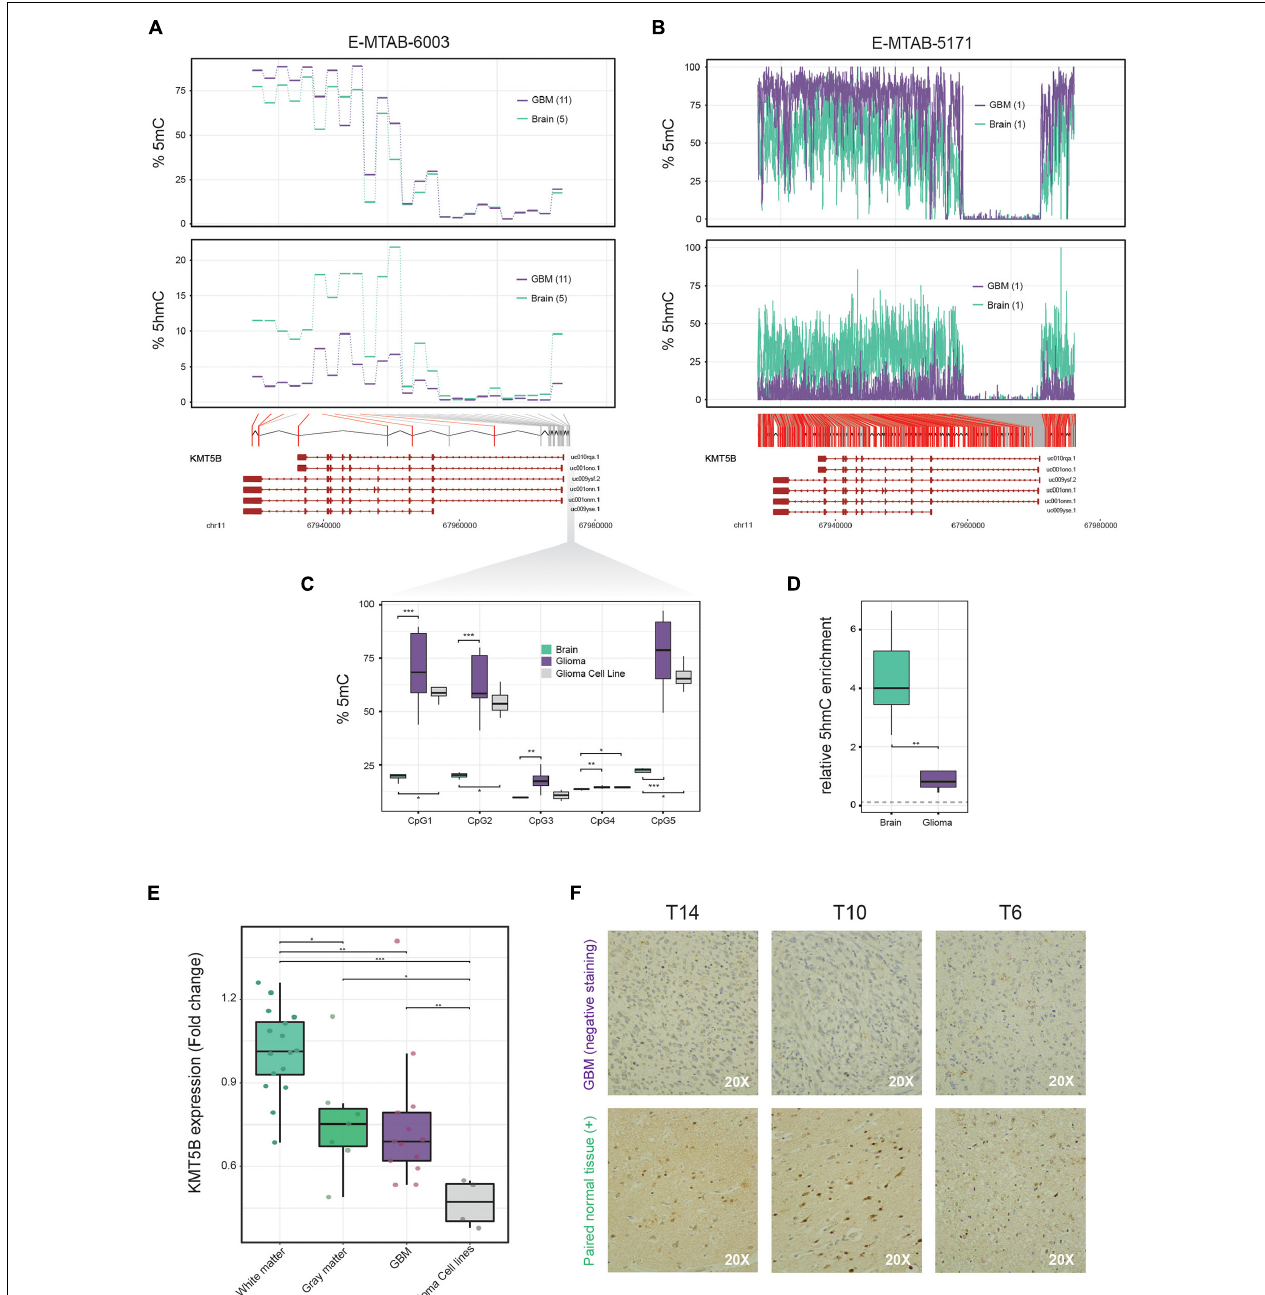
FIGURE 1 | 5mC and 5hmC profiling along the KMT5B locus in brain and glioblastoma multiforme (GBM) samples and analysis of KMT5B expression in brain, GBM and GBM cell lines. (A) Line plots represent percentage of average 5mC ( upper panel ) and 5hmC values ( lower panel ) corresponding to 25 CpG positions in the KMT5B gene for five control brain and eleven GBM samples, depicted in blue and violet, respectively. Data were obtained from a genome-wide Illumina HumanMethylation 450 K array (E-MTAB-6003). Welch t -tests were applied for each CpG and those that were significant are depicted in red ( q -value < 0.05). (B) WGBS dataset with high content profiling of 5mC and 5hmC (accession number E-MTAB-5171) confirmed the altered 5mC/5hmC pattern of KMT5B . CpGs depicted in red represent those with changes =15%. Lower diagrams in panels (A,B) represent the relative location of the analyzed CpG sites along KMT5B locus. (C,D) Biological validation of the methylation and hydroxymethylation values in five KMT5B promoter CpGs using, respectively, bisulfite pyrosequencing and hMeDIP. The gray dotted line in panel (D) indicates 5hmC levels in GBM cell line LN-229. Wilcoxon rank sum tests were applied (* p < 0.05; ** p < 0.01; *** p < 0.001). (E) Box plot represents KMT5B mRNA relative expression in 16 white matter and 7 gray matter control brains, 13 GBM samples and 4 GBM cell lines, measured by qRT-PCR in relation to GAPDH and represented as Fold Change relative to white-matter control brains. Wilcoxon rank sum tests were applied (* p < 0.05; ** p < 0.01; *** p < 0.001). (F) Representative images of KMT5B protein levels detected in GBM samples and their paired non-tumoral brain tissue by immunohistochemistry (IHC), shown at 20 × magnification. Only non-tumoral brain sections showed positive KMT5B nuclear